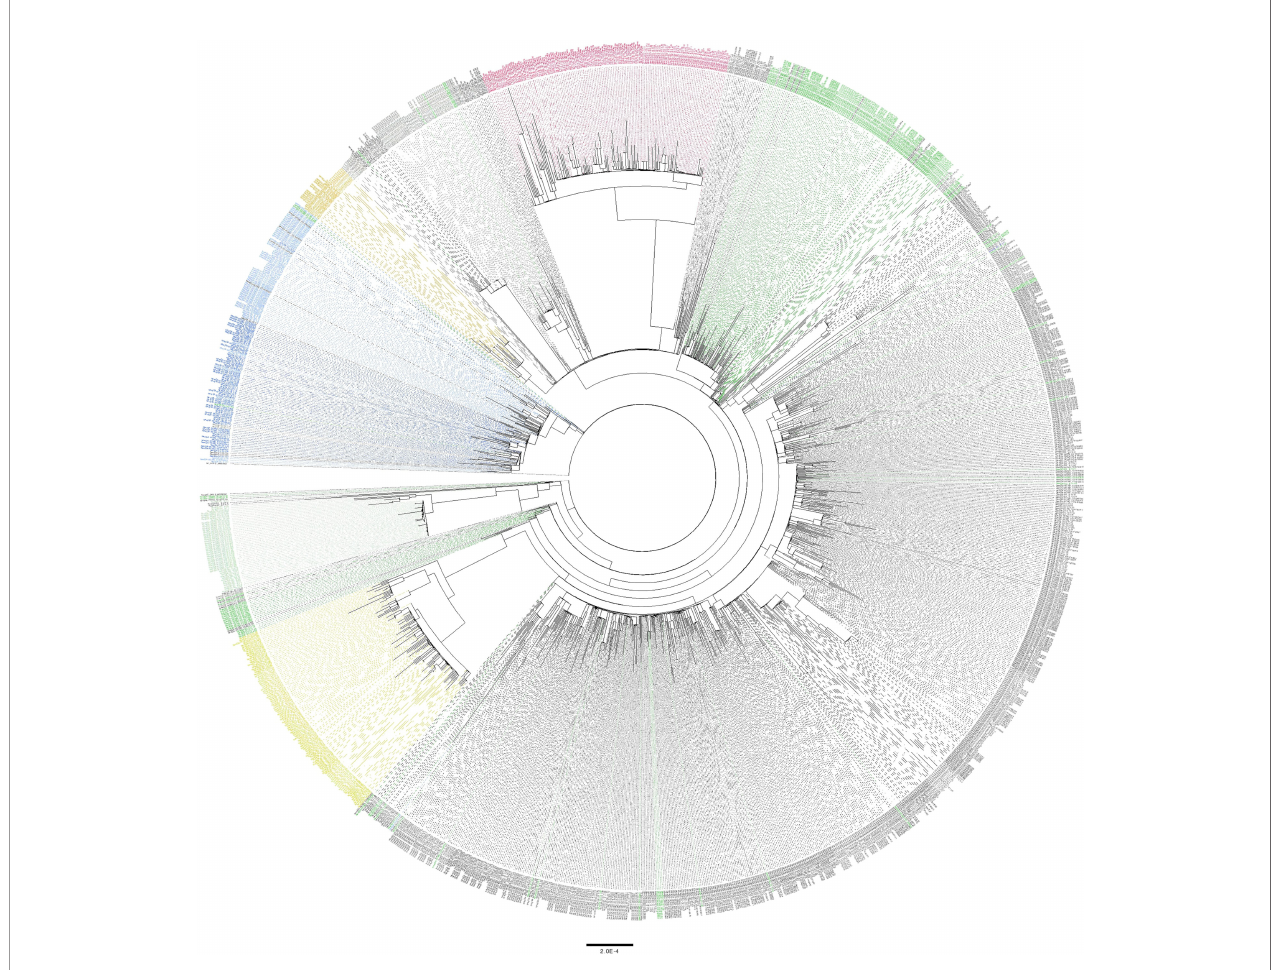
FIGURE 4 | Maximum likelihood tree of high-coverage SARS-CoV-2 genomes included in this study. Phylogenetic tree was generated using 1,452 high-coverage genomes (>90%) sequenced during the period from March 2020 to March 2021. SARS-CoV-2 lineages are indicated in colors as follows: A in light green, B in light blue, B.1 in dark green, B.1.1 in grey, B.40 in in dark blue, B.1.1.75 in light brown, B.1.1.7 in bright red and B.1.351 in yellow. All other lineages are colored in